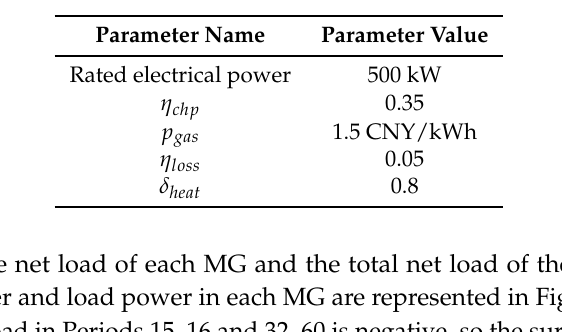
Table 6. Parameters of combined heat and power (CHP) in MG1.